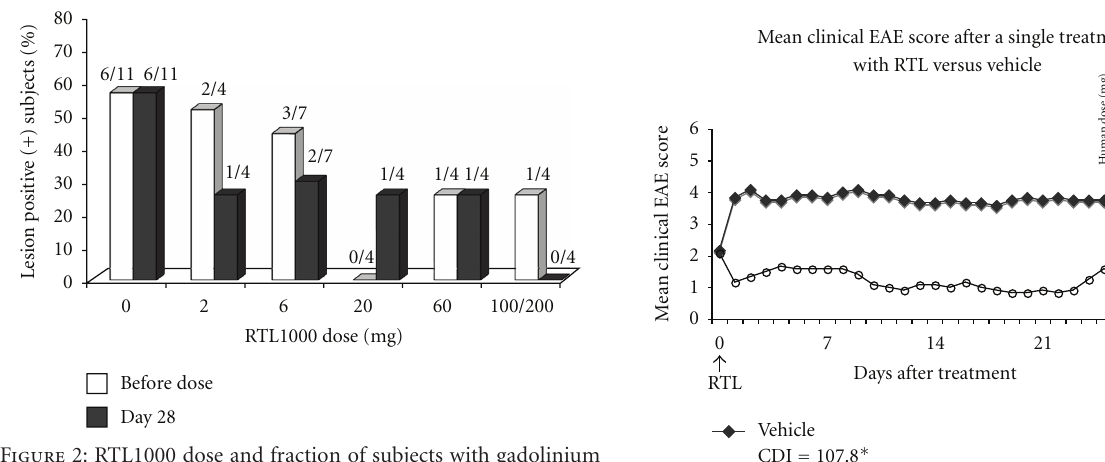
Figure 2: RTL1000 dose and fraction of subjects with gadolinium enhancing lesions at baseline and 28 days after infusion: gadolinium enhancing lesions were scored for each subject at baseline (before dose) and 28 days after infusion of RTL1000 or placebo and the percentage of subjects with ≥ 1 GAD-enhancing lesion is indicated for each dosing group.